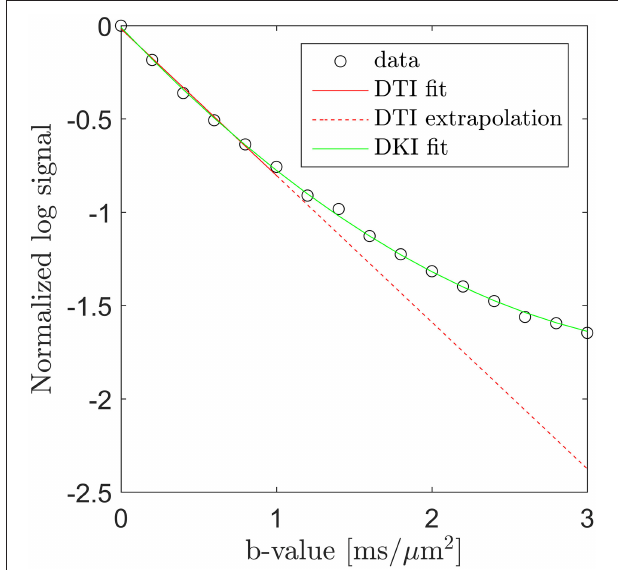
FIGURE 1 | Diffusion MRI data (circles) from a white matter region in human brain acquired along one direction over the b -value range from 0 to 3 ms/ µ m 2 . Fits obtained with DTI (solid red line, b 0–1 ms/ µ m 2 ) and DKI (green line, all = b -values) are shown. The signal deviation from the DTI signal prediction is illustrated by extrapolating the DTI fit (the dashed red line) into the DKI regime ( b > 1 ms/ µ m 2 ). Conversely, the DKI fit is seen to approximate the signal very